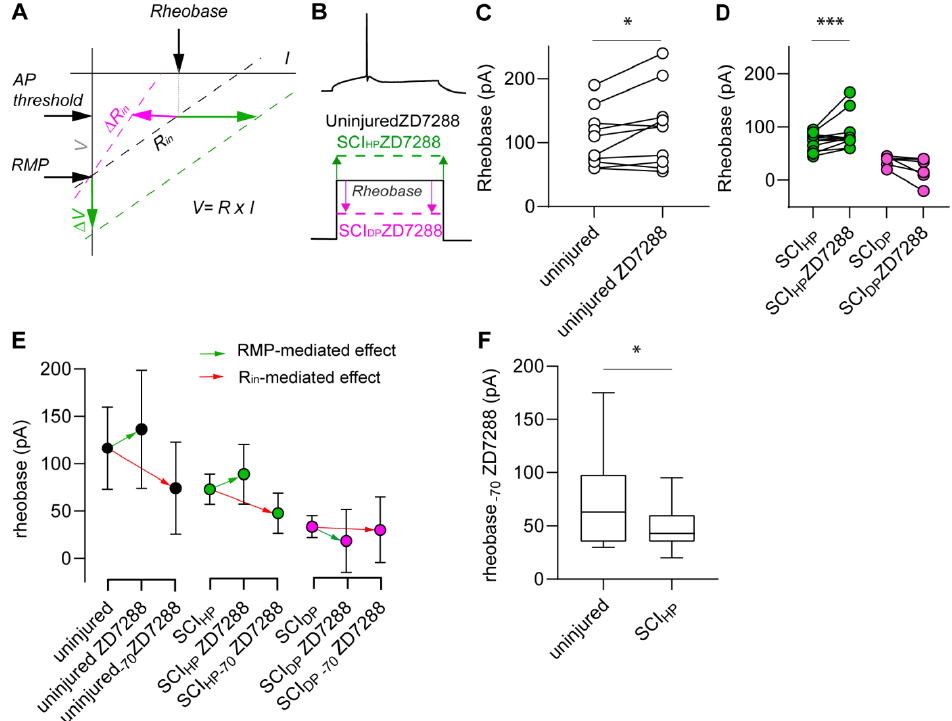
Figure 4. ZD7288 has RMP-mediated effects and R in -mediated effects that influence the rheobase of M1LV neurons. ( A ) The linear relation between voltage and current (V = R × I) explains why RMP hyperpolarization contributes to increased rheobase per se (green arrows), while reduced R in has the opposite effect per se (red arrows). Note: Upon ZD7288 application, both effects are combined. ( B – D ) Current clamp experiments reveal different effects of ZD7288 on the rheobase of ( C ) uninjured neurons, ( C ) SCI HP neurons, and ( D ) SCI DP neurons. ZD7288 causes a significant increase of rheobase in uninjured neurons. ( D ) Increased rheobase occurs in SCI HP , and a slight decrease in rheobase occurs in SCI DP ( E ). RMP-mediated effects of ZD7288 on the rheobase (green arrows) are prevented by equalizing the baseline voltage to −7 0 mV (close to RMP of untreated neurons). Thus, the R in -mediated effects of ZD7288 are highlighted by a strong decrease in rheobase (red arrow) in uninjured and axotomized neurons alike, with the exception of SCI DP . ( F ) In the presence of ZD7288 and from an equalized baseline voltage of −7 0 mV, the rheobase of SCI DP neurons is significantly lower than that of uninjured neurons. * p < 0.05; *** p < 0.0001.